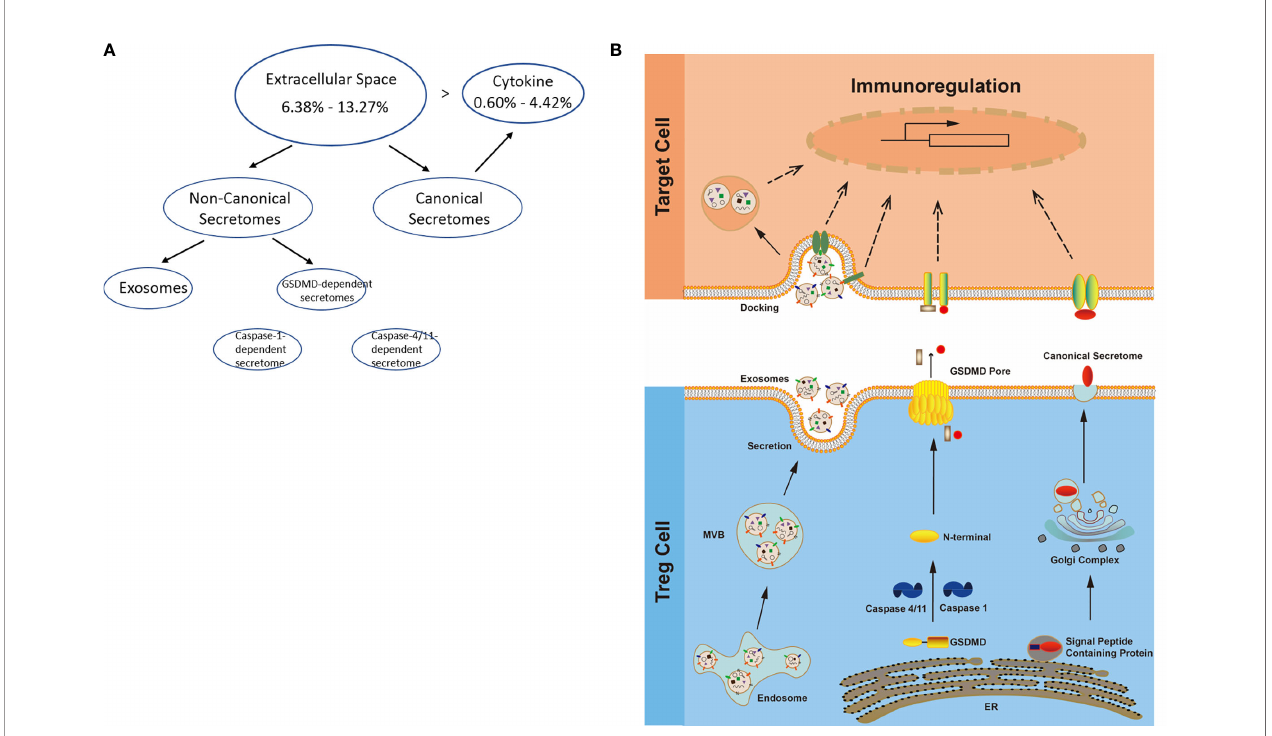
FIGURE 3 | (A) Several secretomic pathways of Treg may contribute to the compositions of extracellular space molecules from Treg. In all the datasets, the percentages of extracellular space molecules were varied from 6.38 to 13.27%, which were much higher than the percentages of cytokines. Therefore, numerous additional non-canonical secretome molecules were existed in the extracellular space. The mechanisms of canonical and non-canonical secretome transportation were shown in Figure 1B . (B) The secretion mechanisms such as canonical (proteins with signal peptide) and non-canonical secretomes (proteins with no signal peptide) may contribute to the Treg secretory molecule repertoire. The proteins in canonical secretory pathway are secreted via endoplasmic reticulum (ER)-Golgi complexes-plasma membrane pathway (right in the lower panel). In contrast, proteins having no signal peptide are secreted via caspase-1-gasdermin D (GSDMD) pore/channel-dependent pathway (center in the lower panel), caspase-4 (humans)/11 (mice)-GSDMD-dependent pathway (center in the lower panel) and exosome pathway (left in the lower panel). Treg may use these secretomic proteins (including all the cytokines and chemokines) to ful fi ll their immunoregulatory functions by binding to their receptors or docking on exosome up-taking mechanisms on the plasma ( Figure 4 ); Treg from injured skeletal muscles (2 weeks) increased more canonical secretomic genes compared to that of Treg from injured skeletal muscles (4 days); Treg from regeneration kidney increased more canonical secretomic genes compared to that of Treg fi brosis kidney. In the benign disease Treg group as shown in Table 2B , a total of 24 activated pathways were enriched in upregulated secretomic genes. P38 MAPK signaling were shared in fi ve Treg groups including splenic Treg (injured muscle for 2 weeks), splenicTreg (injured muscle for 4 days), skeletal muscle Treg (injured muscle for 2 weeks), skeletal muscle Treg (injured for 4 days), and Treg from fi brosis kidney. STAT3 pathway was shared in two kidney Treg sets. IL-6 signaling was increased in skeletal muscle Treg (injured for 4 days). Four of the canonical secretome pathways were speci fi c in E-MTAB-7961 Treg from kidney regeneration dataset, including hepatic fi brosis signaling pathway, PDGF signaling, VEGF signaling, and VEGF family ligand-receptor interactions, which may carry functions of tissue repair. IL-6 signaling was speci fi cally enriched in GSE50096 Treg from muscle injury 4 days dataset, which was in the acute reaction phase after muscle injury.